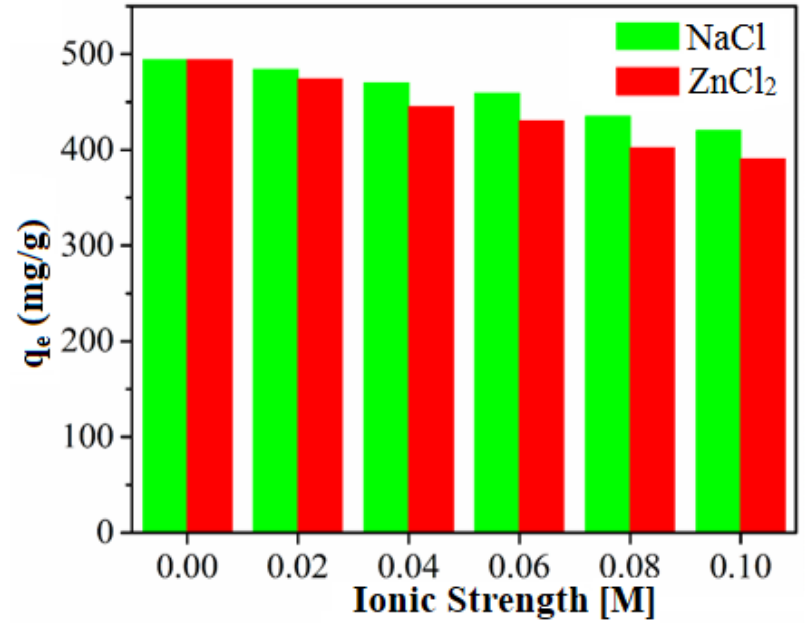
Figure 10. Effect of NaCl and ZnCl 2 on adsorption system.